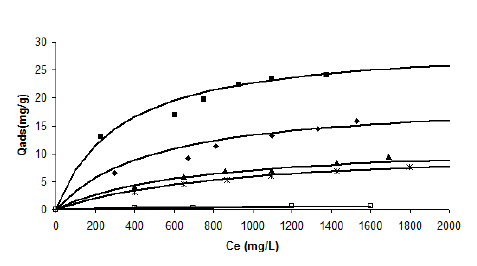
Figure 5. Adsorption isotherms of para Chlorophenol on -ØN-R20 [ ], -3N-R20 [ ], -1N-R20 [ ], -S-R20 [*] and unmodi- fied SBA [ ] Isotherms described by the Langmuir model.